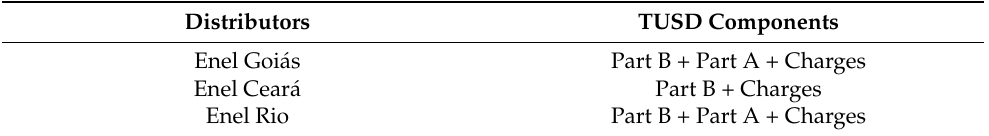
Table 3. TUSD components for calculating the impact of MMDG on the utility readjustment and tariff review, based on data from ANEEL